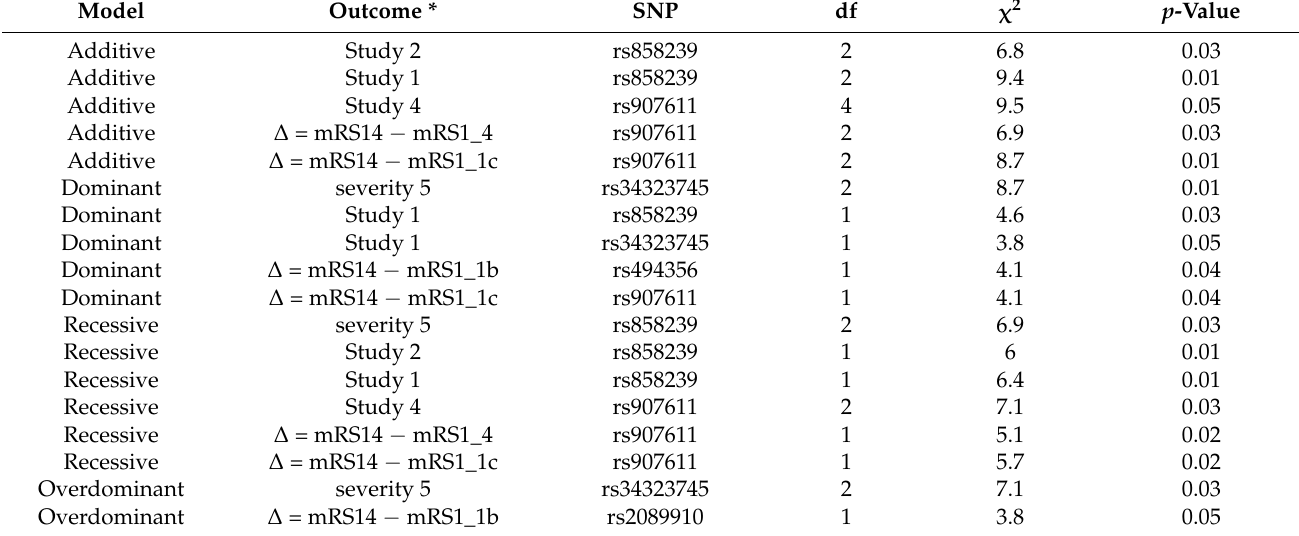
* Severity 5: mRS scores of 0–2 vs. scores of 3 vs. scores of 4–6; ∆ = mRS14 − mRS1_1a: ∆ mRS < 0 vs. ∆ mRS > 0; ∆ = mRS14 − mRS1_1b: ∆ mRS < 0 vs. ∆ mRS = 0; ∆ = mRS14 − mRS1_1c: ∆ mRS > 0 vs.